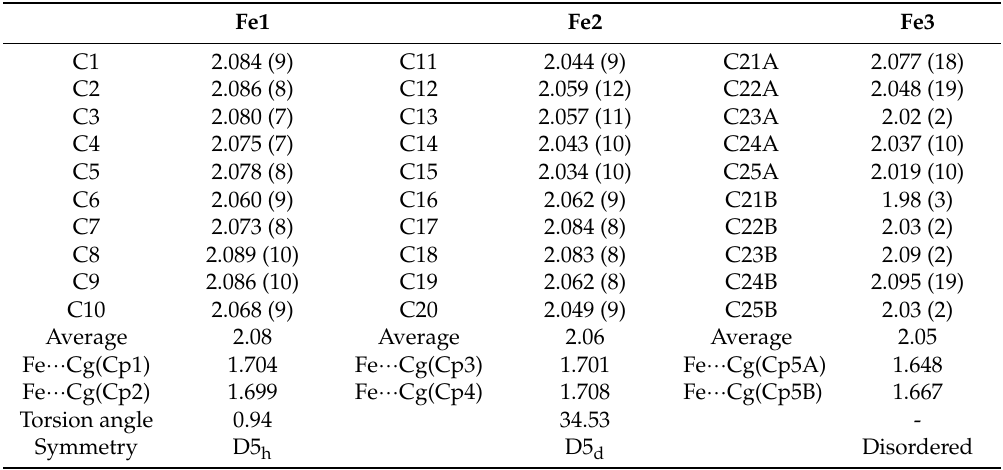
Table 1. Selected geometrical parameters (Å, ◦ ) for the three crystallographically independent ferrocenyl species in 1